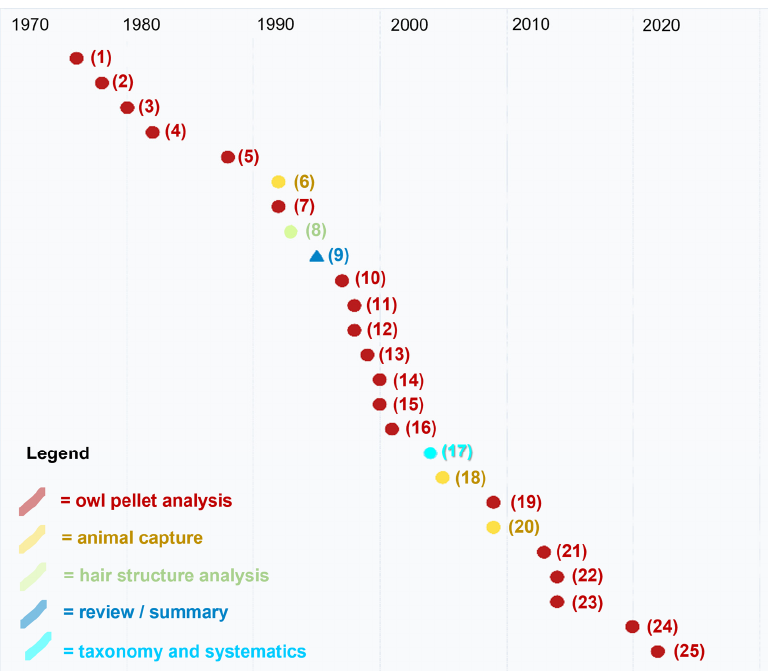
Figure A1. Published works in 1976–2022 dealing with harvest mice in Italy. Different topics are labeled with different shapes and colours. Numbers refer to publication number shown in Table A1.